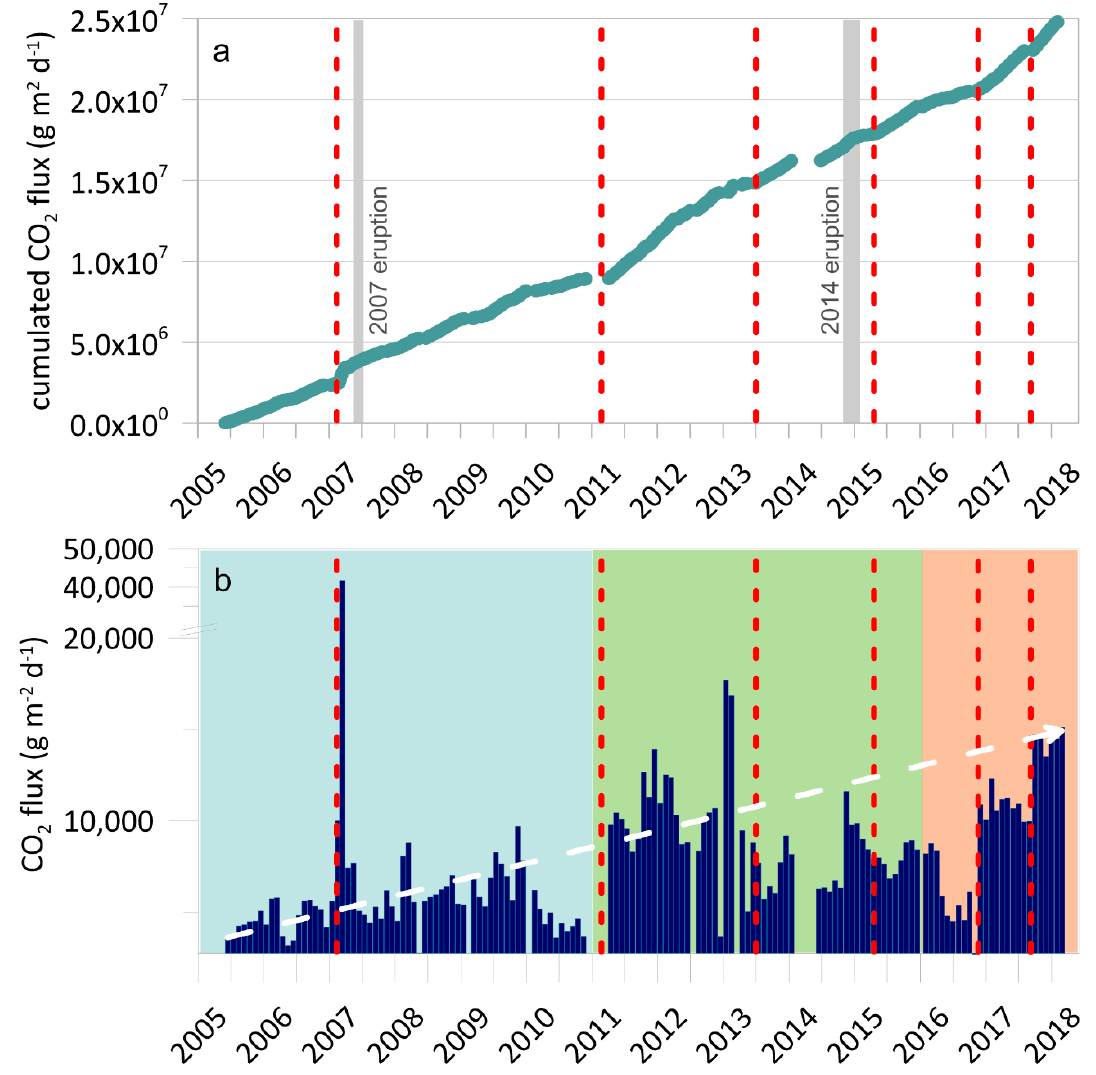
Figure 5. ( a ) Cumulative CO 2 flux vs. time, the inflection points marked with dashed red lines indicate the abrupt changes of degassing style (transient modification); ( b ) monthly average of CO 2 fluxes at STR02 station, the significant large continuous increasing trend of CO 2 flux is evident (white dashed arrow) that indicates a long-lasting modification of the pressure of the shallow plumbing system.